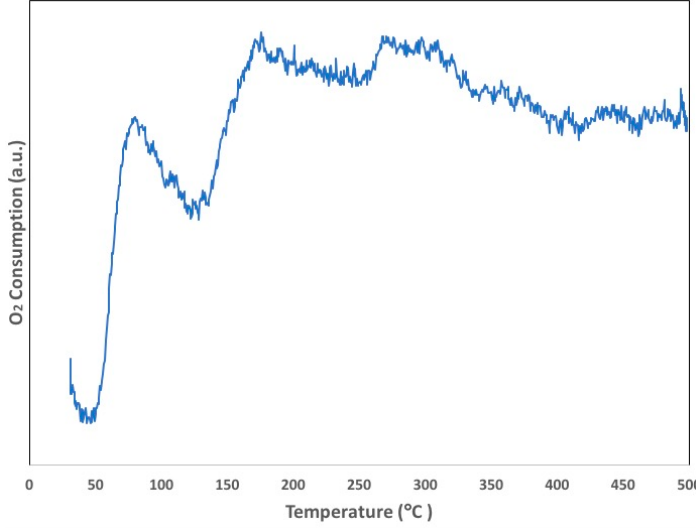
Figure 9. Temperature-programmed oxidation (TPO) of the catalyst.